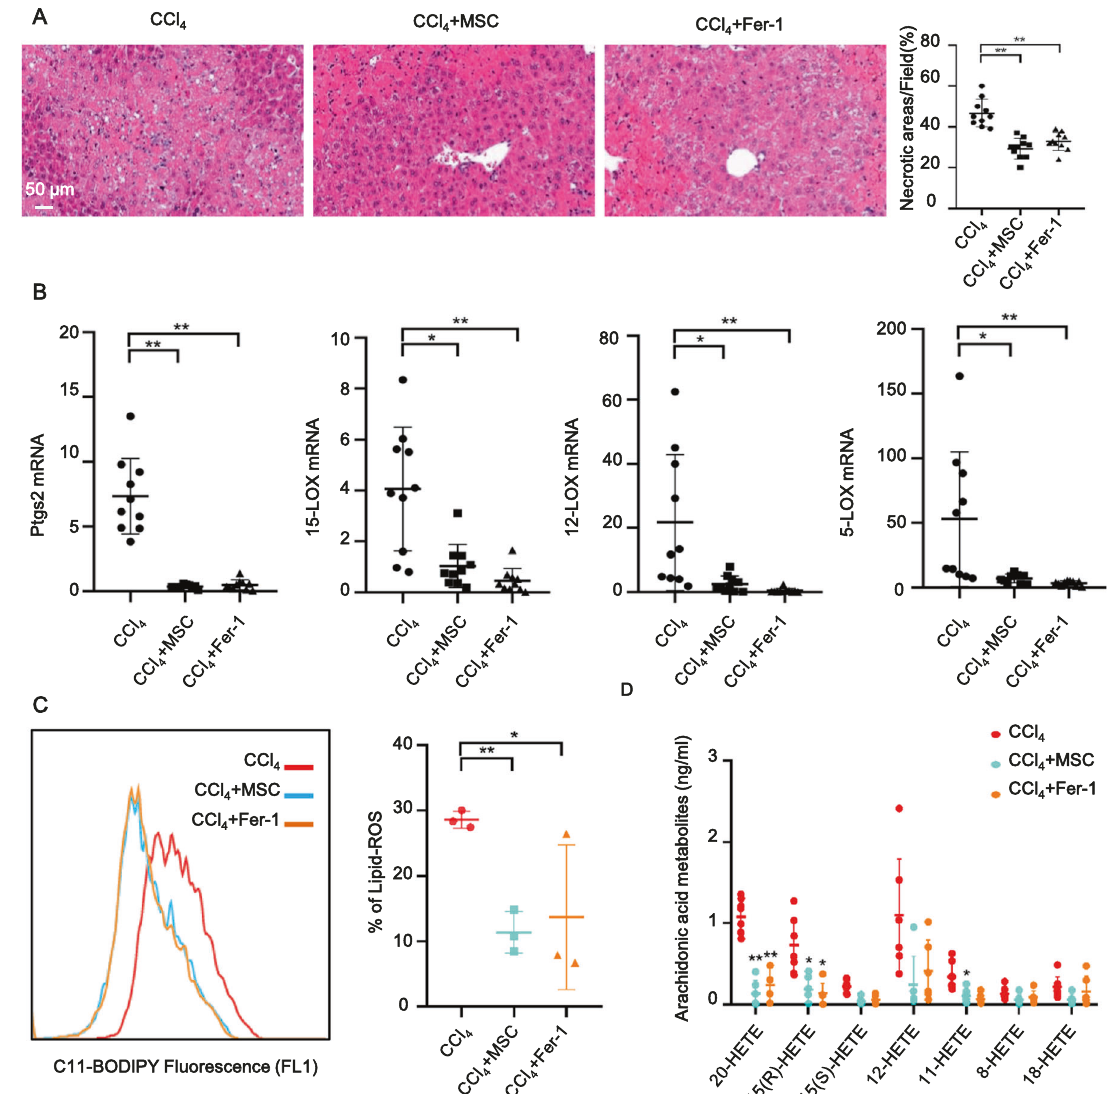
Fig. 2 MSC treatment prevented CCl 4 -induced ferroptosis in ALI. A HE staining showed that MSC and ferrostatin-1 (Fer-1) treatment alleviated CCl 4 -induced ALI. B Ptgs2, 15-LOX, 12-LOX , and 5-LOX mRNA levels were measured in mouse livers of CCl 4 , MSC, and Fer-1 groups. mRNA levels were normalized to that of GAPDH. C Lipid peroxidation was measured by C11-BODIPY 581/591 staining. Lipid peroxidation of hepatocytes in the liver was signi fi cantly increased in the CCl 4 group but signi fi cantly reduced in MSC and Fer-1 groups. D UPLC-MS/MS detection showed increased levels of 20-hydroxyeicosatetraenoic acid (HETE), 15(R)-HETE, 15(S)-HETE, 12-HETE, 11-HETE, 8-HETE, and